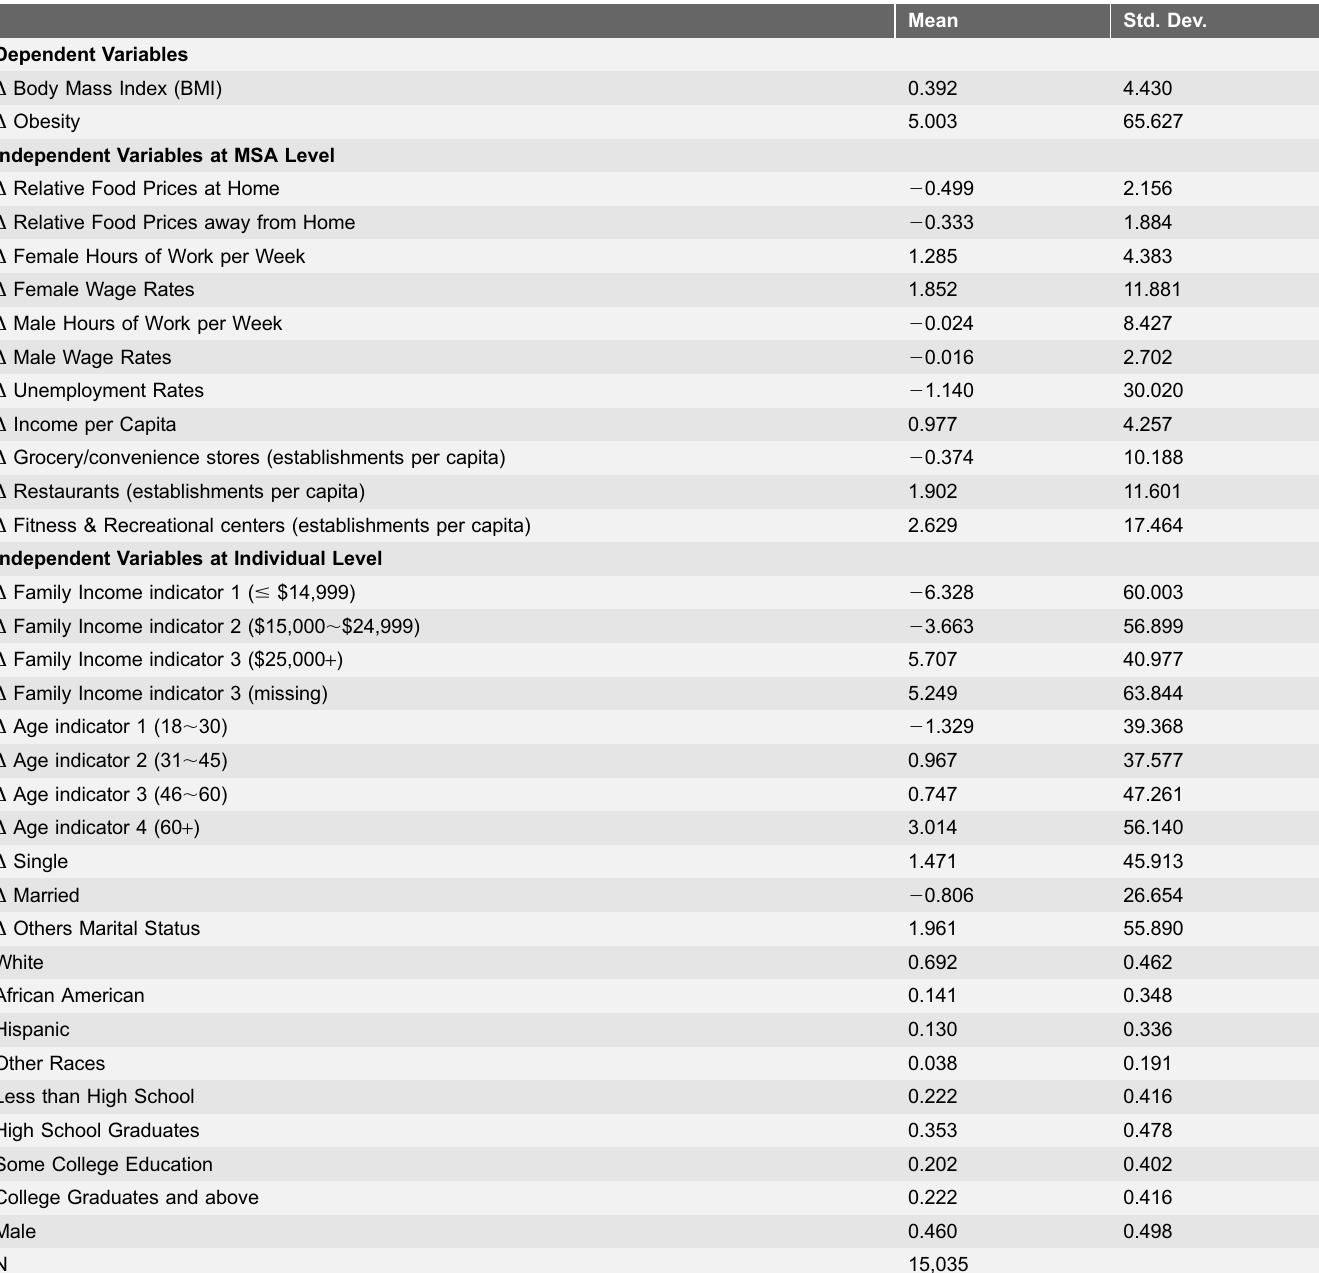
Table 1. Summary Statistics of Aggregate Samples: